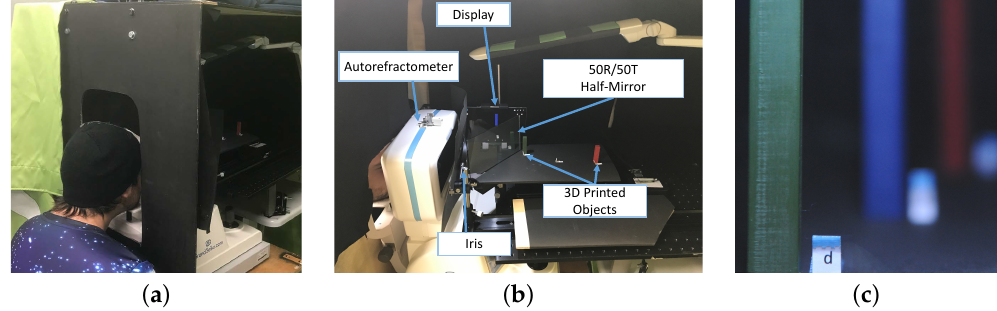
Figure 5. Our experiment setup: ( a ) a user sitting in front of the autorefractometer and looking inside the box enclosure (the side panel was opened for illustrative purposes); ( b ) internal view of the box enclosure; ( c ) user’s